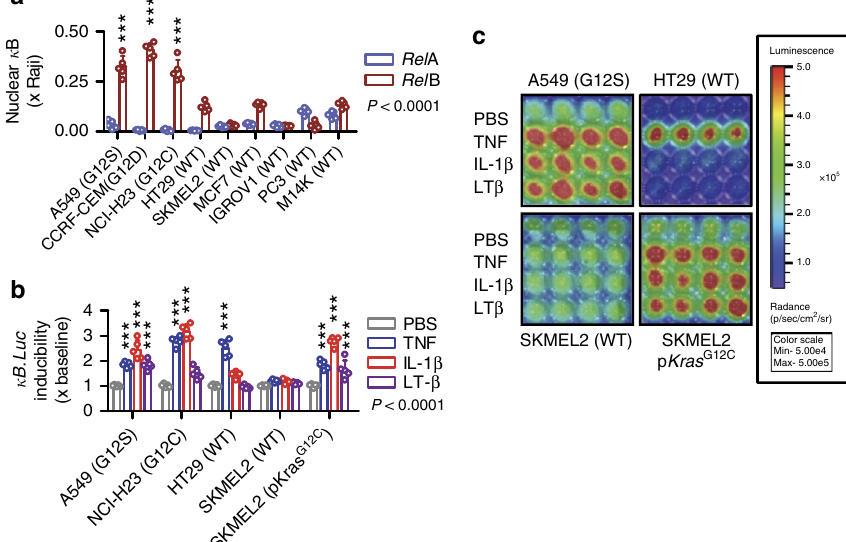
Fig. 10 Non-canonical endogenous and IL-1 β -inducible NF- κ B activation of KRAS -mutant human tumor cells. Different human cancer cell lines